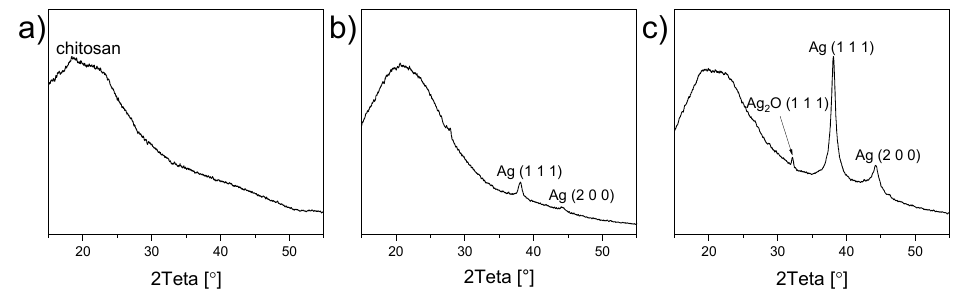
Figure 8. The XRD diffractograms of ( a ) blank chitosan and chitosan/Ag NP composites prepared using the discharge with ( b ) liquid cathode and ( c ) liquid anode. Treatment time, 30 min. The spectrum corresponding to blank chitosan shows a broad peak with a maximum of 2 θ = 20°, related to the amorphous chitosan [20] (Figure 8a). This signal is also present in chitosan/Ag NP be attributed to the Ag crystalline phase in the orientation of (1 1 1) and (2 0 0). In agreement with the